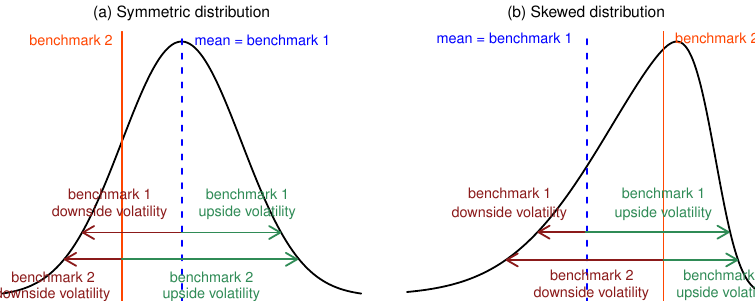
Figure 1. ( a ) With a symmetric distribution and a benchmark equal to the mean, downside and upside volatility are equally split; ( b ) With a skewed distribution or a benchmark different from the mean, downside and upside volatility are